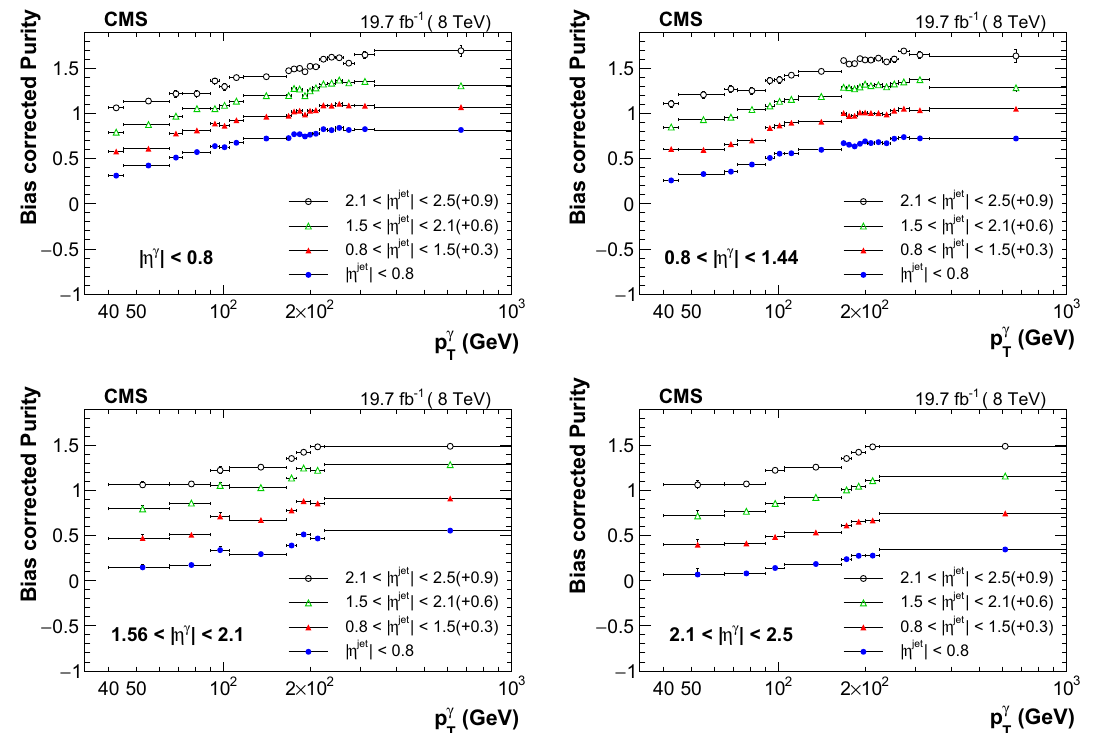
γ Fig. 2 Purity estimates as a function of p for different photon and jet pseudorapidity regions. The values are offset by 0.3, 0.6 and 0.9 for T 0 . 8 < | η jet | < 1 . 5, 1 . 5 < | η jet | < 2 . 1, and 2 . 1 < | η jet | < 2 . 5 respectively. The total uncertainties are shown as error